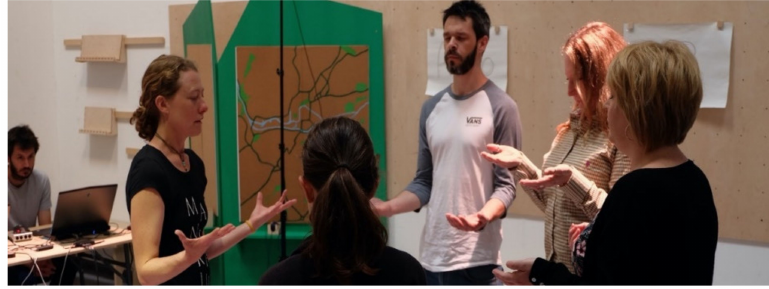
Figure 4. TFS workshops, task 2—Knowle West Media Centre,